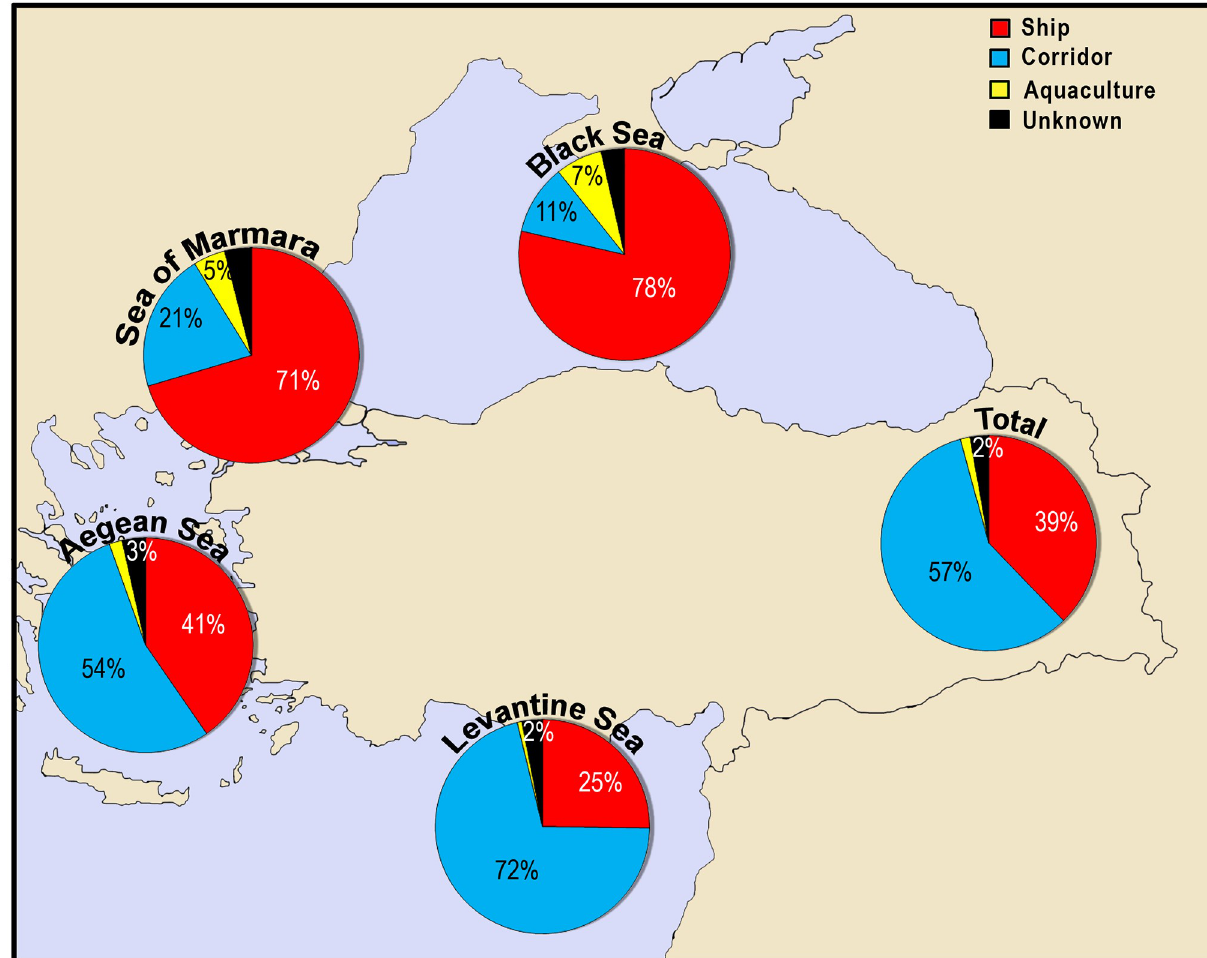
Fig 9. The primary pathways of introduction for the alien species along the coasts of